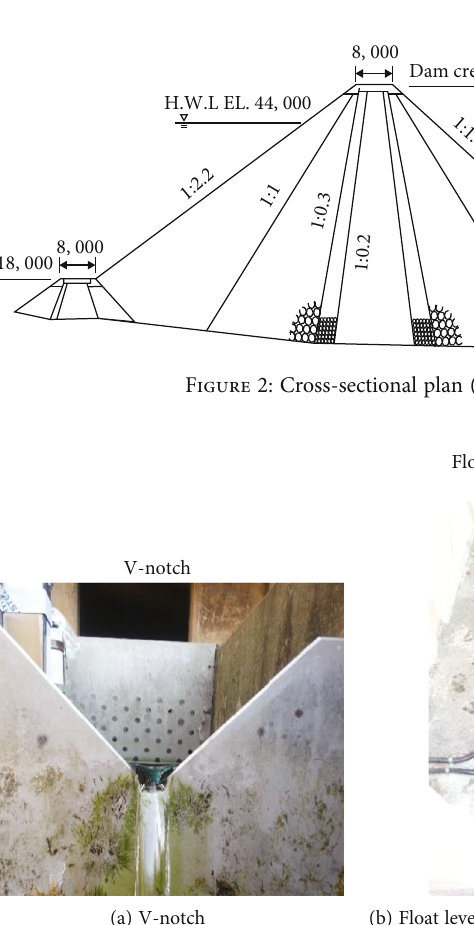
Figure 3: Instruments for measuring seepage of a fi ll